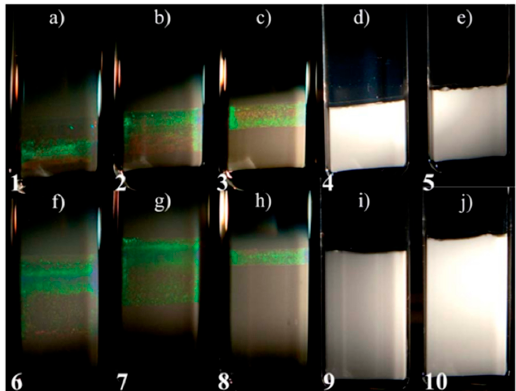
Figure 15. Samples of gibbsite/silica suspensions after one year of sedimentation. Samples ( a – e ) are 4 vol% gibbsite and 2, 3, 5, 7, and 8 vol% of silica particles, respectively. Samples ( f – j ) have 8 vol% gibbsite and 2, 3, 5, 7, and 8 vol% of silica particles, respectively. Reprinted with permission from